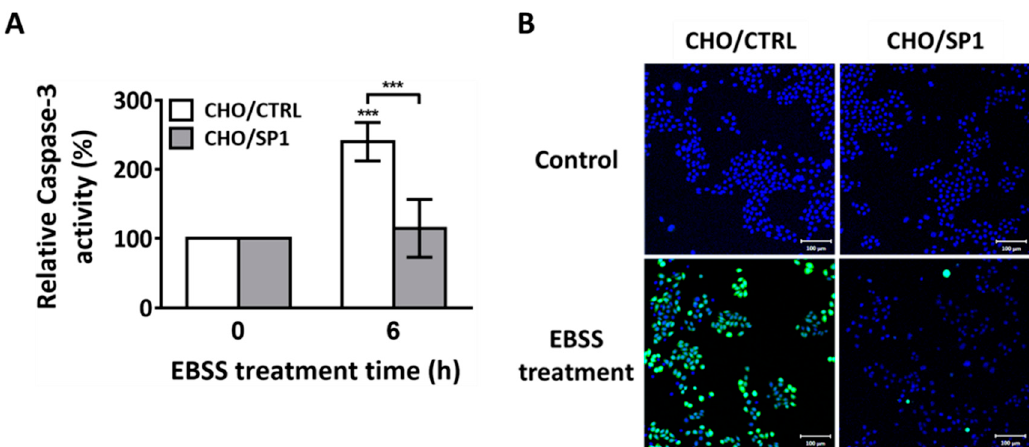
Figure 2. Effects of SP1 on caspase-3 activation and reactive oxygen species (ROS) generation in the EBSS-treated CHO cells. ( A ) The effect of SP1 on caspase-3 activity after autophagy induction. The cells were treated with EBSS for 6 h, and caspase-3 activity was assessed using the caspase-3 substrate N-Acetyl-Asp-Glu-Val-Asp-7-amido-4-Trifluoromethylcoumarin (Ac-DEVD-AFC). ( B ) The effect of SP1 on the ROS generation in cells under starvation. ROS levels were measured using the cell permeant 2 ʹ ,7 ʹ -dichlorodihydrofluorescein diacetate (H 2 DCFDA), and were analyzed by performing fluorescence microscopy. The cells were treated with EBSS for 0 and 4 h, and were stained with H 2 DCFDA (green) for measuring intracellular ROS levels and with Hoechst 33342 (blue) for staining the nucleus. All values are represented as mean ± SD (*** p < 0.001; n = 3).